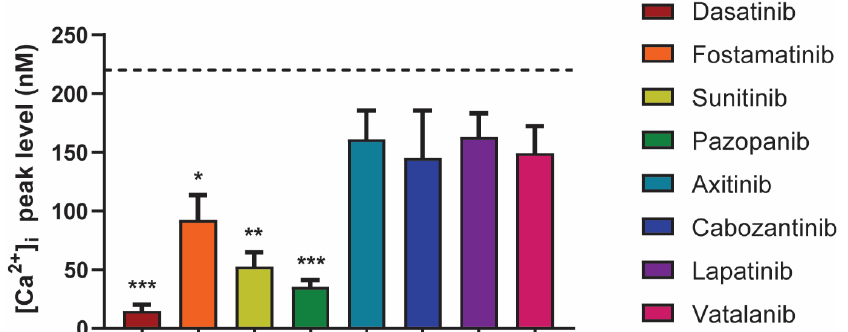
Figure 4. Effects of different TKIs on GPVI-induced intracellular calcium responses. Fura-2-loaded platelets (200 × 10 9 / L) were pre-incubated with vehicle, dasatinib (100 nM), fostamatinib (33 μ M), sunitinib (10 μ M), pazopanib (10 μ M), axitinib (33 μ M), cabozantinib (10 μ M), lapatinib (33 μ M), or vatalanib (10 μ M) for 10 min and stimulated with CRP-XL (10 µg/mL) in the presence of 2 mM CaCl 2 . The histograms show the maximal rises in [Ca 2+ ] i ( n = 6). The black dotted line indicates the average of the control values. Data are shown as means ± SEM; * p < 0.05, ** p < 0.01, and *** p < 0.001.